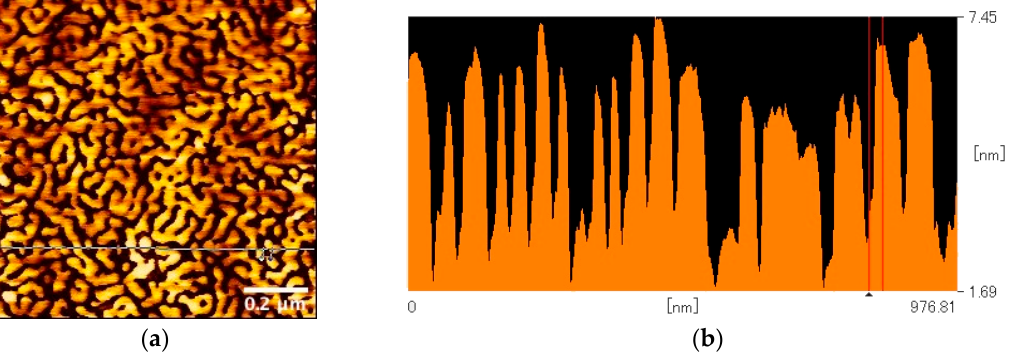
Figure 1. ( a ) Topographic image (1 × 1 μ m) and ( b ) section plot of scanning force microscope (SFM) of the thin film by spin-casting the solution of poly(styrene- b -butadiene- b -styrene) (SBS) (0.5 wt%) in a mixture of chloroform and anisole (70:30 ( v / v )). The distance between the red lines in the section plot corresponding to the half-domain spacing is 24.8 nm.